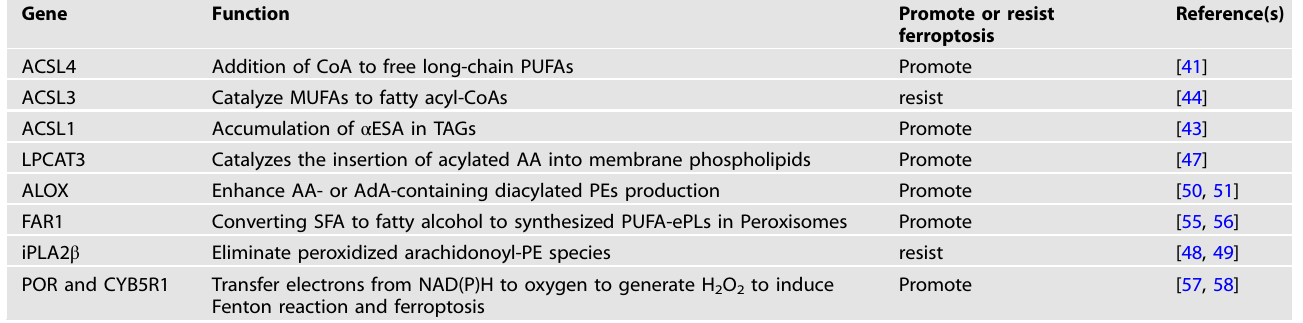
Table 2. Cellular localization and function of ferroptosis resistance genes. Gene Function Location Reference SLC7A11 Mediates the cystine/glutamate antiporter to GSH synthesis. Membrane [62] GPX4 Converting peroxidized PUFA-containing PLs to non-toxic PL-OH. Cytoplasm, mitochondrion FSP1 NAD(P)H-dependent CoQ oxidoreductase to suppress lipid peroxidation and ferroptosis via reducing CoQ to CoQH 2 . DHODH DHODH suppresses mitochondrial lipid peroxidation and ferroptosis in a CoQ- dependent way by converting CoQ to CoQH2 DHFR Mediated regeneration BH4 from BH2. BH4 availability might reduce CoQ to enhance ferroptosis resistance GCH1 The rate-limiting enzyme for BH4